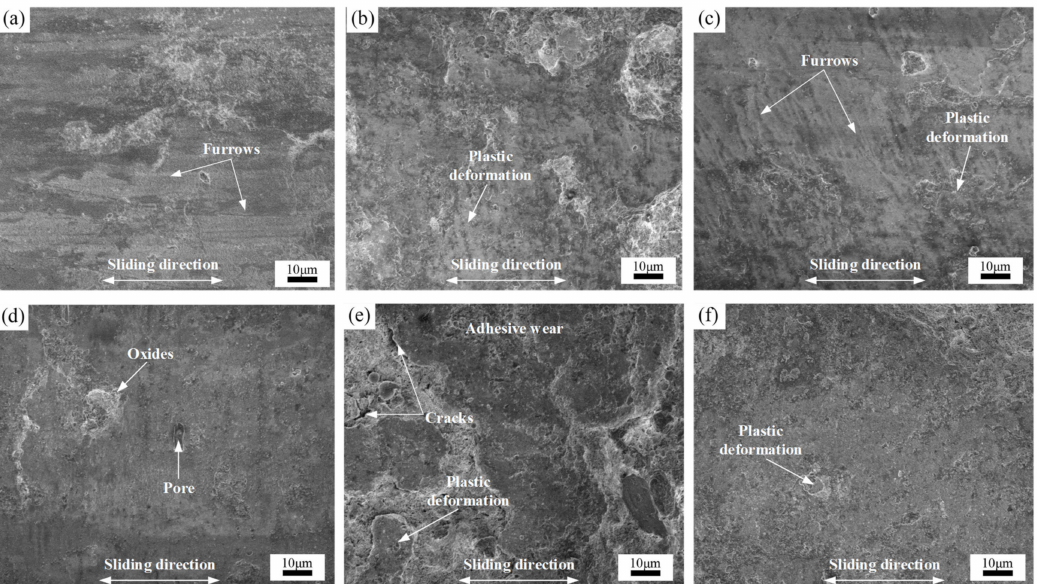
Figure 10. SEM images (SE mode) of worn surfaces of ( a ) as-sprayed coating and coatings annealed at ( b ) 300 ◦ C, ( c ) 400 ◦ C, ( d ) 500 ◦ C, ( e ) 600 ◦ C, ( f ) 700 ◦ C,